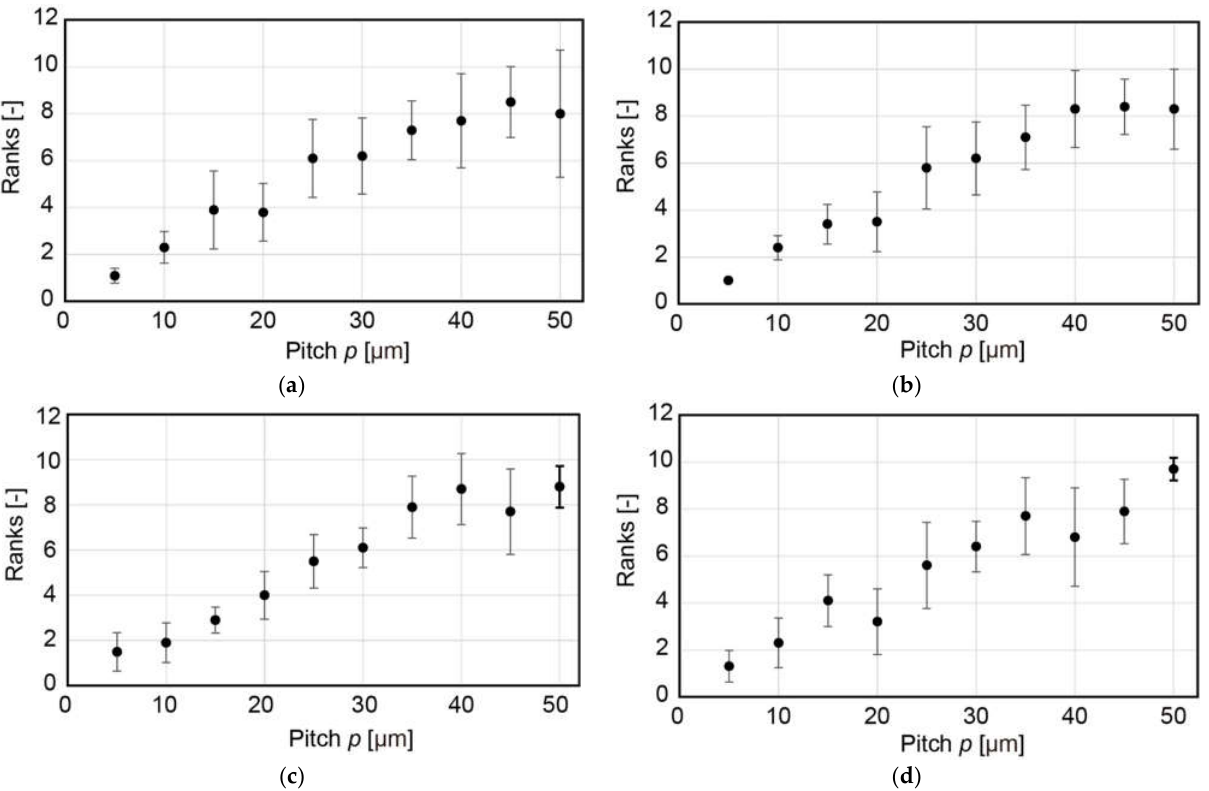
Figure 8. Ranking of dry perception for w values of ( a ) 15, ( b ) 25, ( c ) 40, and ( d ) 45 µ m for various pitch values.